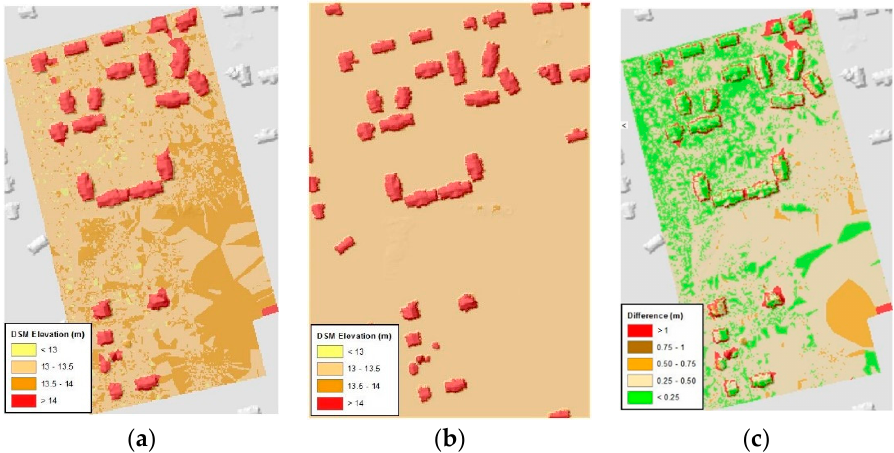
Figure 5. ( a ) UAV-based water surface raster ( b ) LiDAR-based water surface raster ( c ) comparison raster of UAV-based water surface to USGS Stream Level.